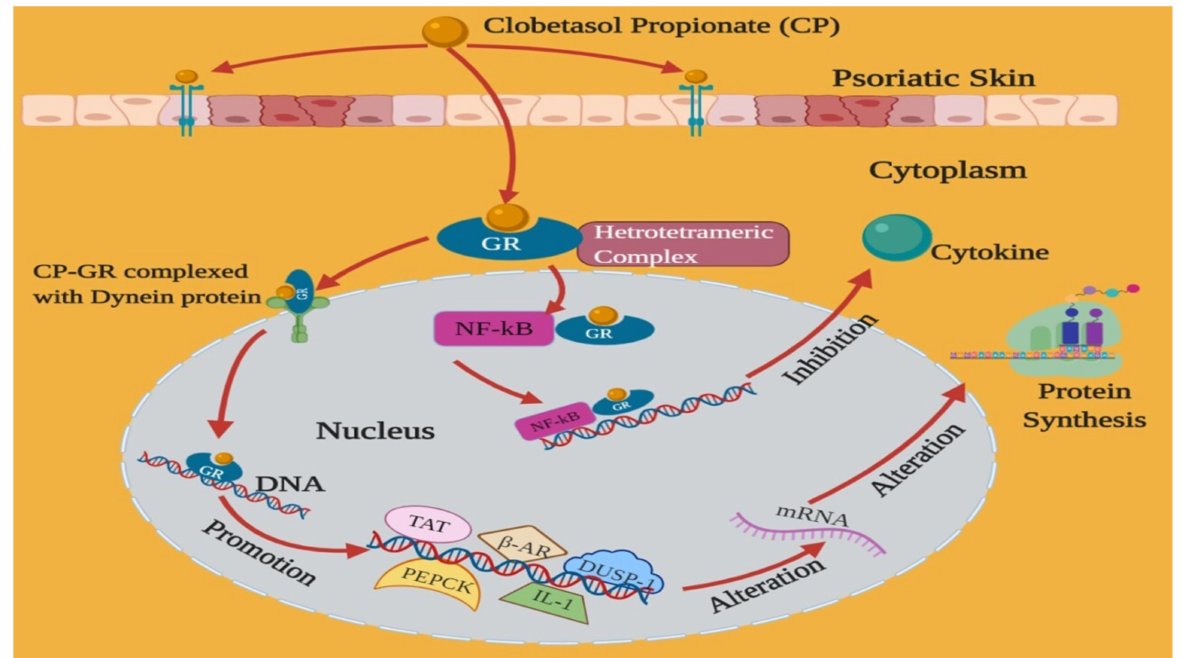
Figure 3. Mechanism of action of clobetasol propionate after topical application. GR—Glucocorticoid Receptor; TAT—tyrosine aminotransferase; PEPCK—phosphoenolpyruvate carboxykinase; β -AR—beta-adrenergic receptor; DUSP—dual-specificity protein phosphate; NF- κ b—nuclear factor kappa-light-chain-enhancer;IL-1—interleukin 1; mRNA—messenger